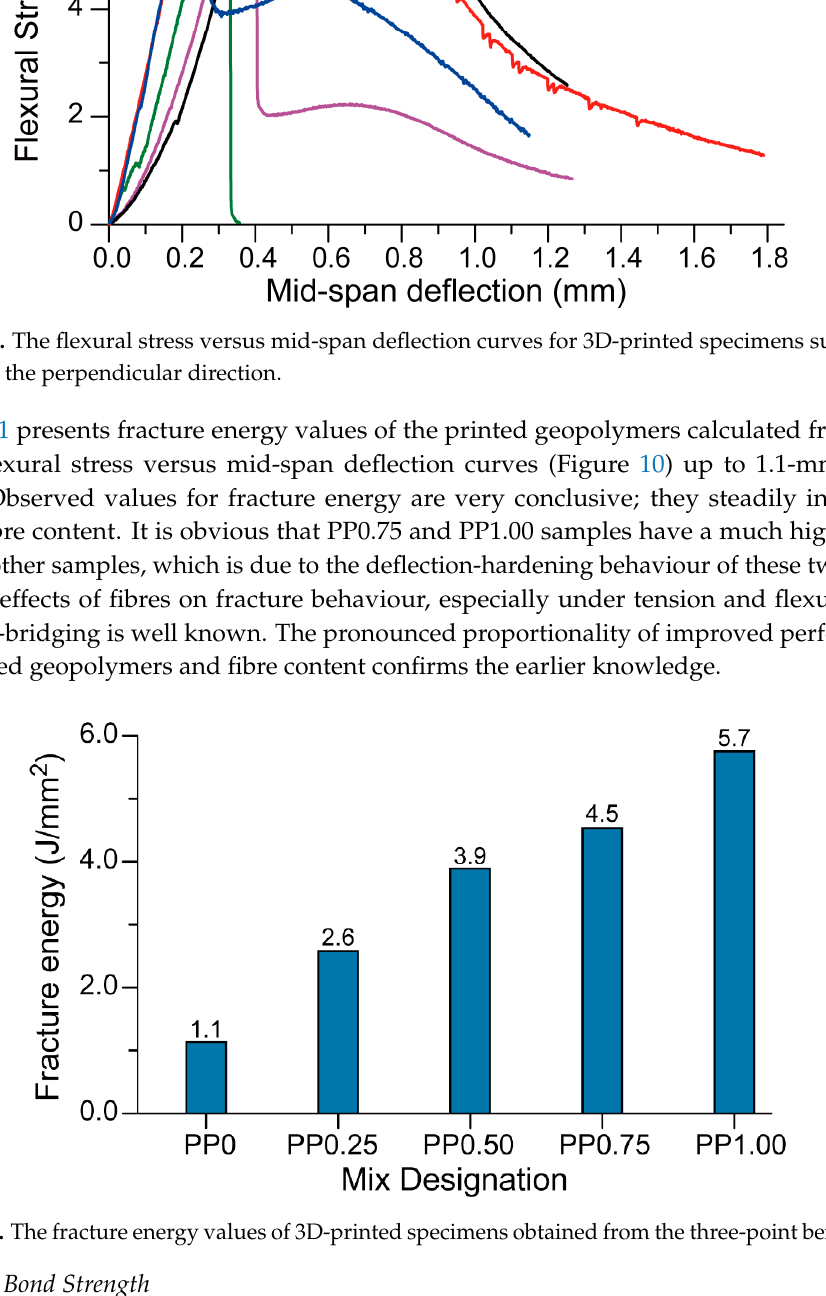
Figure 9. The flexural strength of printed specimens in two different directions.